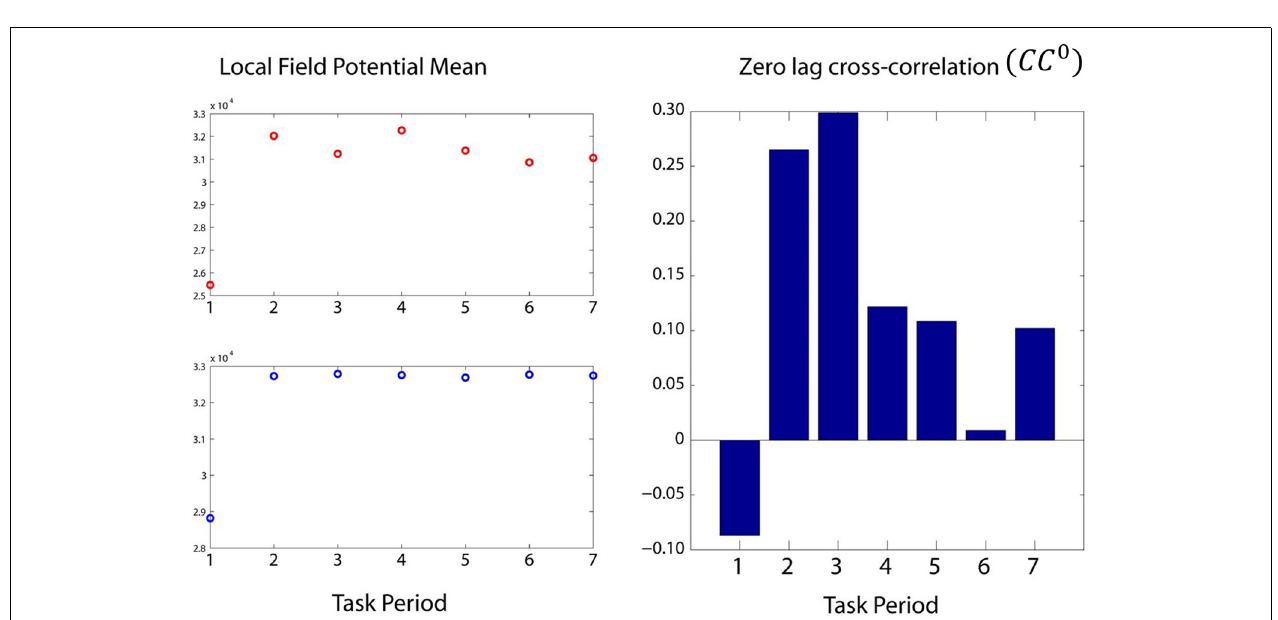
systematic modulation during the subsequent periods. In contrast, zCC 0 was obviously modulated, peaking at period 3, the most cognitively demanding